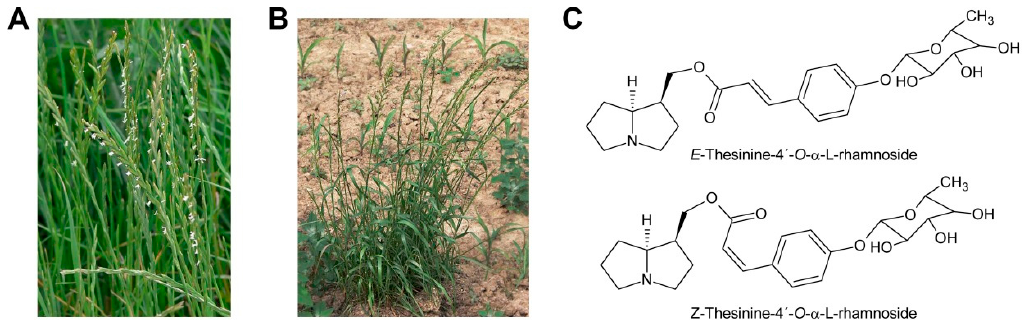
Figure 20. Pyrrolizidine alkaloids reported for Lolium species. ( A ) Lolium perenne (ray grass). ( B ) Lolium multiflorum (Italian rye-grass). ( C ) Structures of E- and Z- thesinine-4 ′ - O - α - L -rhamnoside. Pictures shown in (A) and (B): Courtesy of Leo Michels.